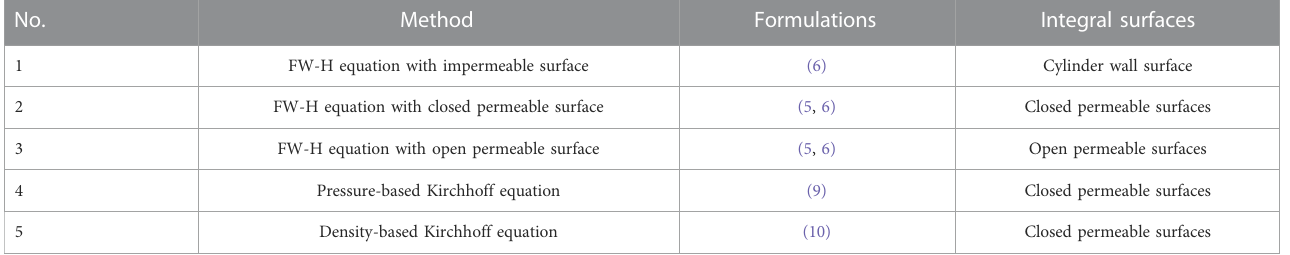
TABLE 2 Comparison of surface integral methods in computational aeroacoustics. No.